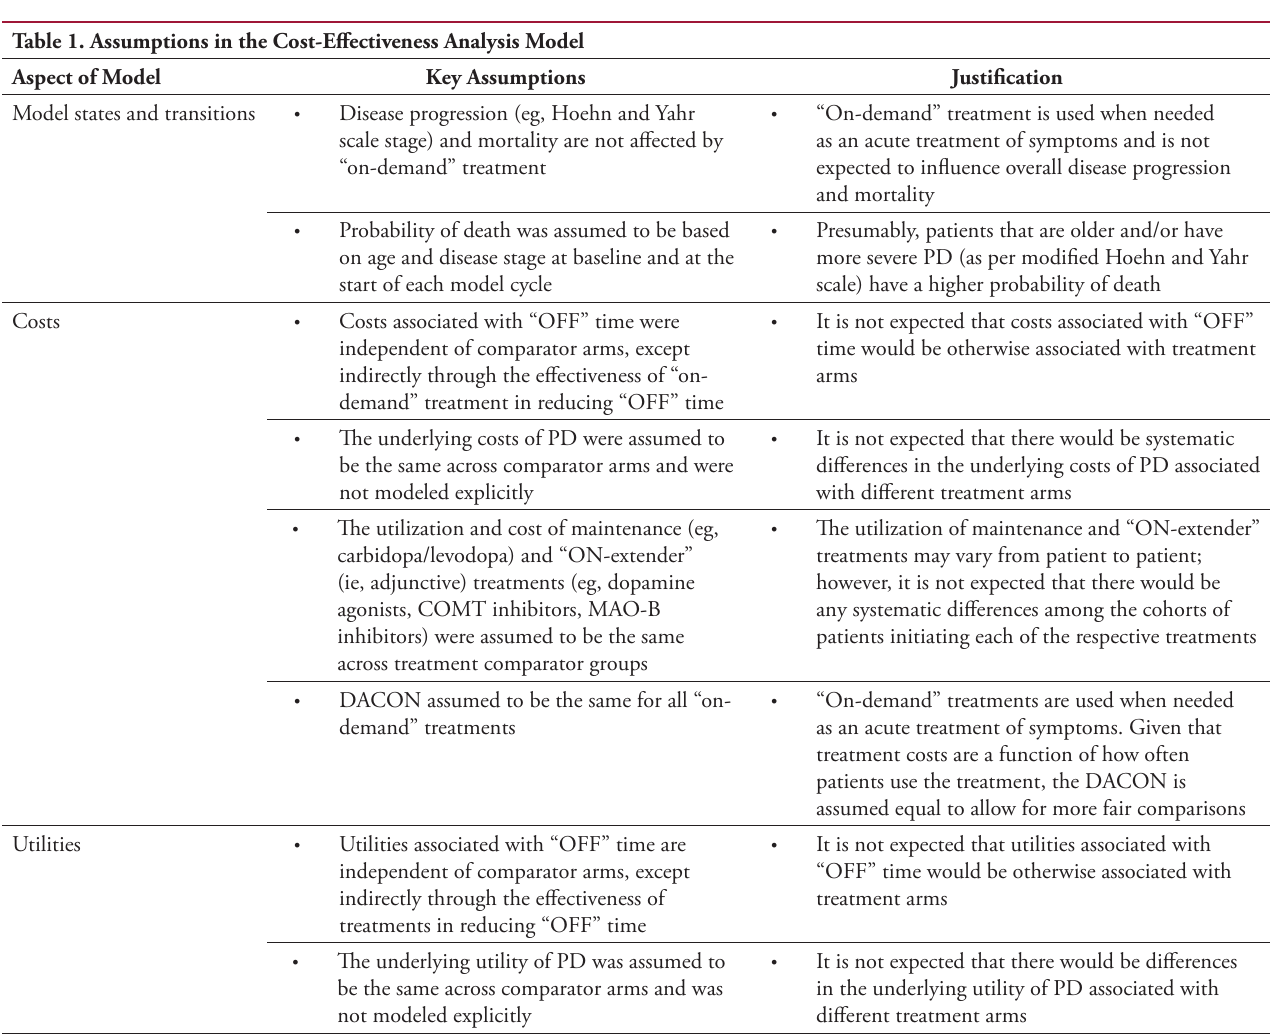
Table 1. Assumptions in the Cost-Effectiveness Analysis Model Aspect of Model Key Assumptions Model states and